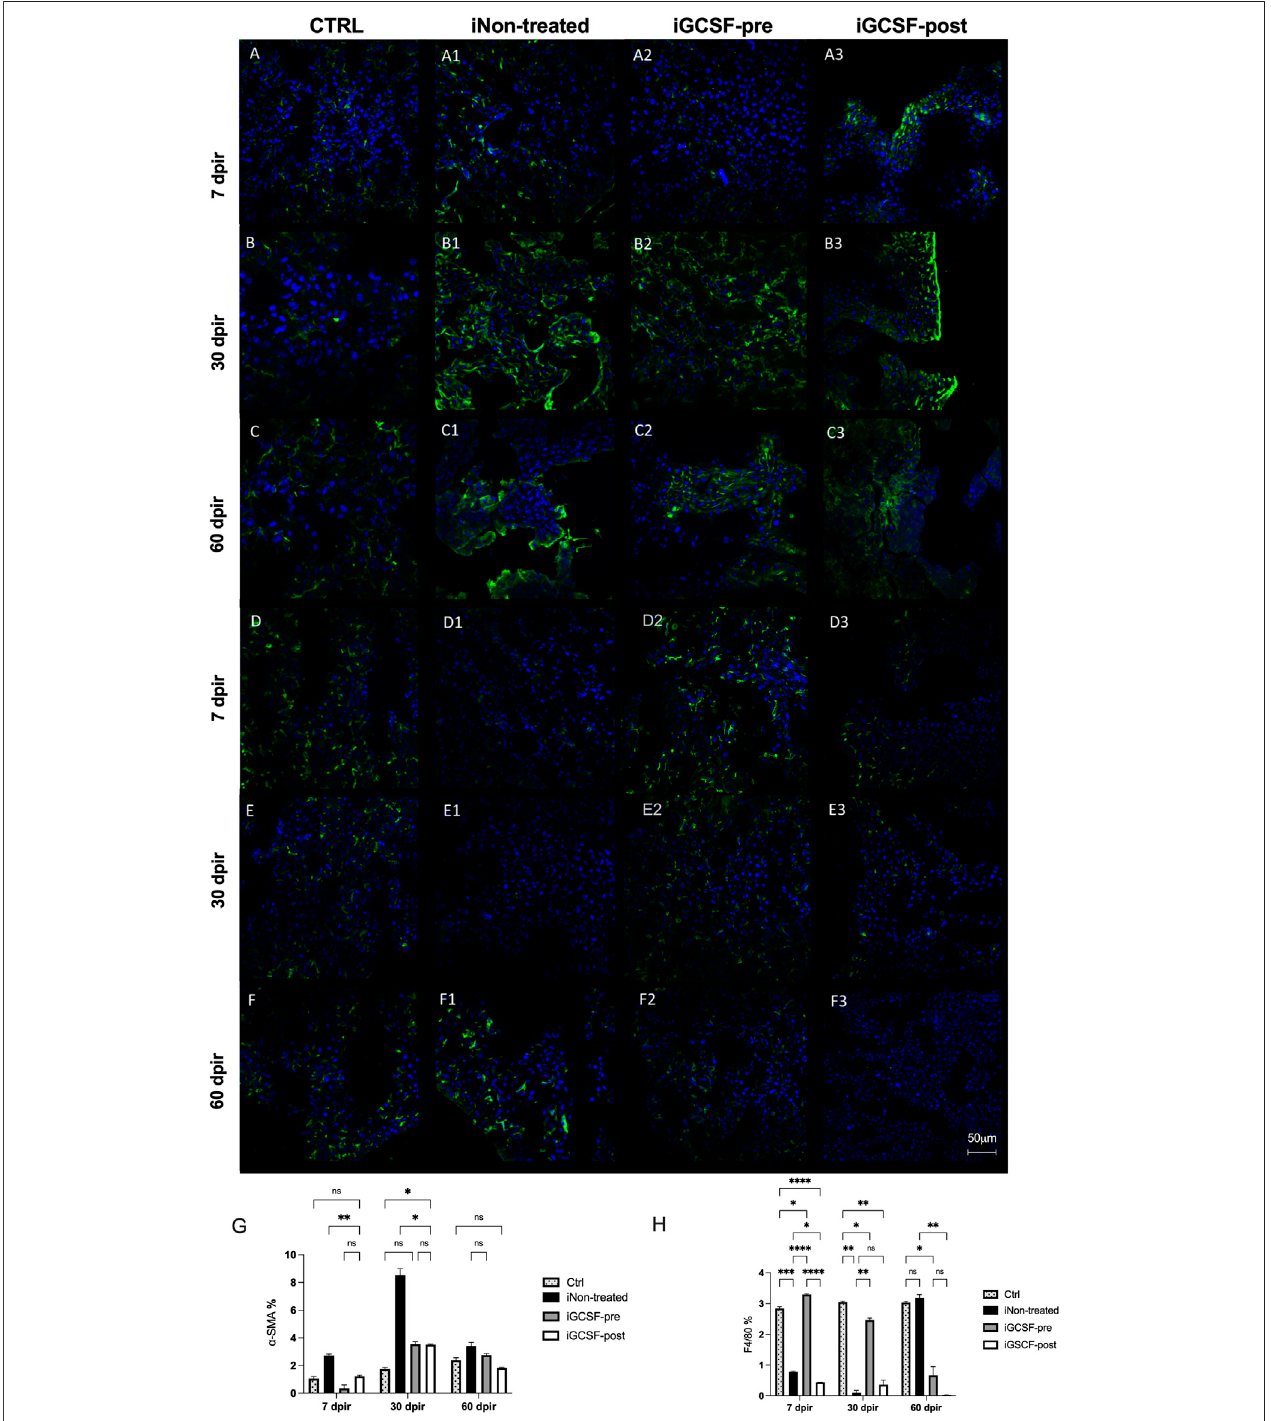
FIGURE 8 | Liver tissue α -SMA and F4/80 protein expression evaluation. Representative images of α -SMA and F4/80 immunostaining from CTRL (A – C,D – F) , iNon-treated (A1 – C1,D1 – F1) , iGCSF-pre (A2 – C2,D2 – F2) and, iGCSF-post group (A3 – C3,D3 – F3) at 7, 30- and 60-day post-irradiation. Immunostaining images revealed positive cells for α -SMA with normal distribution and an increase in the α -SMA protein expression starting from 7 dpir (A) , which gradually increased to 60 dpir (B – C) at CTRL group. In the iGCSF-pre (A2 – C2) group, this increase was observed in 30 dpir (B2) , decreasing slightly by 60 dpir (C2) . In the iGCSF-post Group (A3 – C3) , thisincreasestarted at 7dpir (A3) and continued toincreasesigni fi cantlyat 30and 60 dpir (B3 – C3) .On theotherhand, inthe iNon-treated Groupan increase wasobservedin30dpir (B1) andaslightdecreasewasobservedintheiNon-treatedGroup (C1)